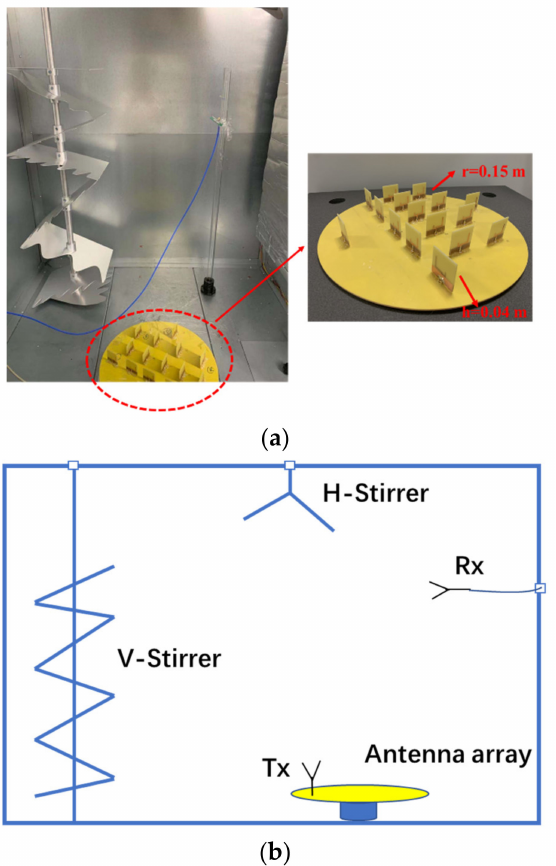
Figure 1. ( a ) Measurement scenario in RC . The dimensions of the RC are 0.938 m × 1.166 m × 1.439 m; the dimensions of the antenna array are: r = 0.15 m, h = 0.04 m. ( b ) Measurement setup in the RC .